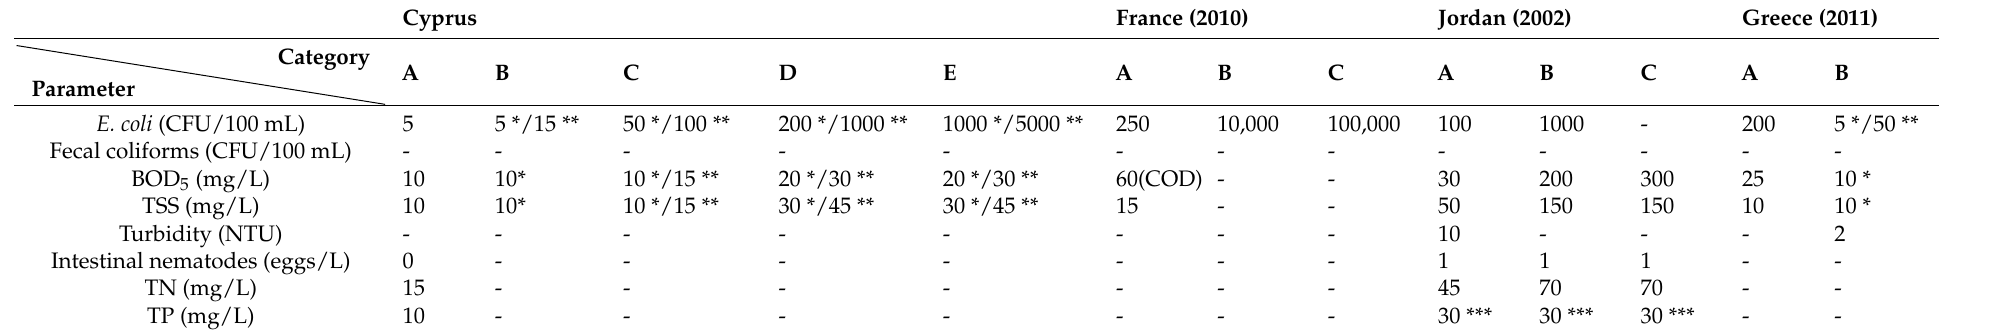
Table 2. Reclaimed water quality guidelines for agricultural reuse for Cyprus, France, Jordan, and Greece. Cyprus